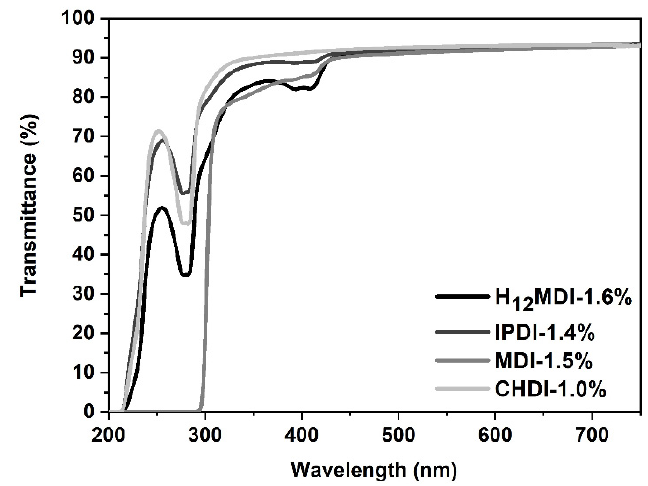
Figure 5. UV–Vis spectra of PSU copolymers synthesized from the aliphatic diisocyanates H 12 MDI, IPDI, and CHDI, and from the aromatic diisocyanate MDI without a chain extender. All PSU copolymers exhibit transmittance values of over 90% between 450 and 750 nm. Transmittance of the PSU copolymer film synthesized from MDI is zero below 300 nm owing to absorption of UV-B radiation by the aromatic rings.